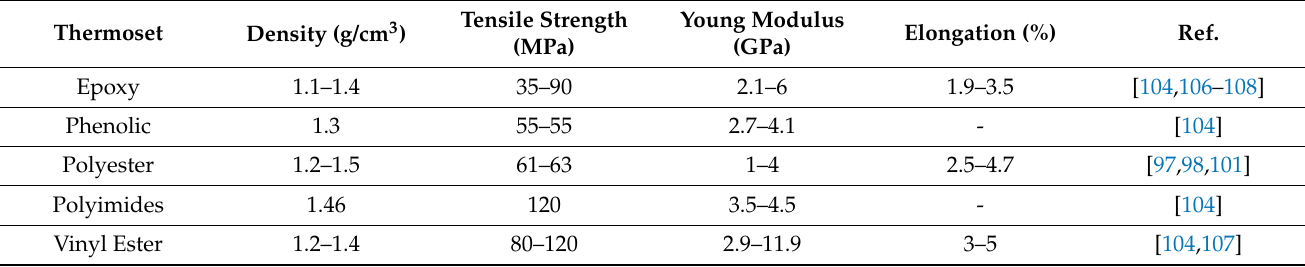
Table 9. Thermoset Properties.